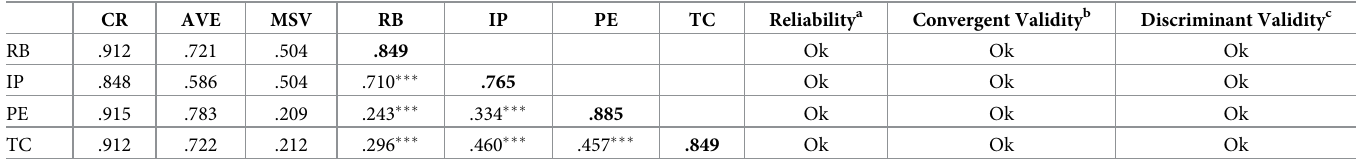
Table 4. Model validity measures of the PCTR-PT (composite reliability, CR; average variance extracted, AVE; maximum shared variance, MSV). CR AVE